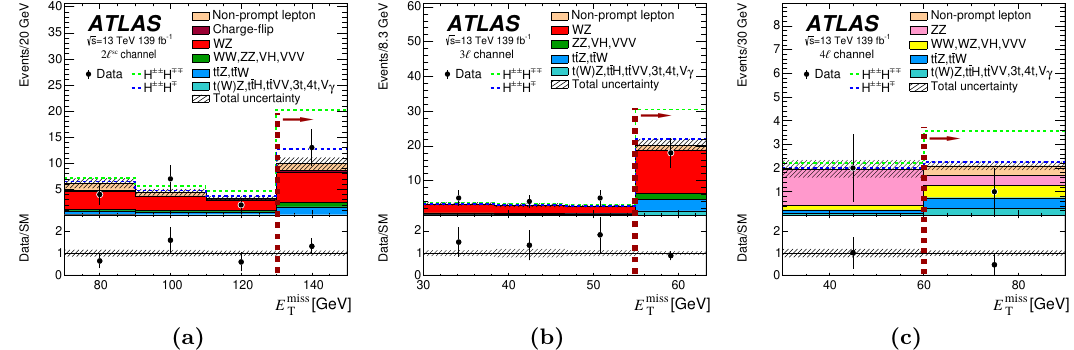
= 300 GeV signal mass hypothesis, Figure 8 . The E miss T distribution for the SRs of the m H ±± where the selection requirement on E miss has been removed. The distribution is shown for the T combination of the individual channels of the (a) 2 ‘ sc , (b) 3 ‘ and (c) 4 ‘ SRs. The total uncertainties in the expected event yields are shown as hashed bands. The last bin, isolated by a vertical red dashed line, is inclusive and corresponds to the SR. The expected signal distributions corresponding to the m = 300 GeV are also shown (stack histogram, on top of the background). In each figure H ±± the bottom panel shows the ratio of data to the estimated background. The hatched band around unity represents the total uncertainty of the